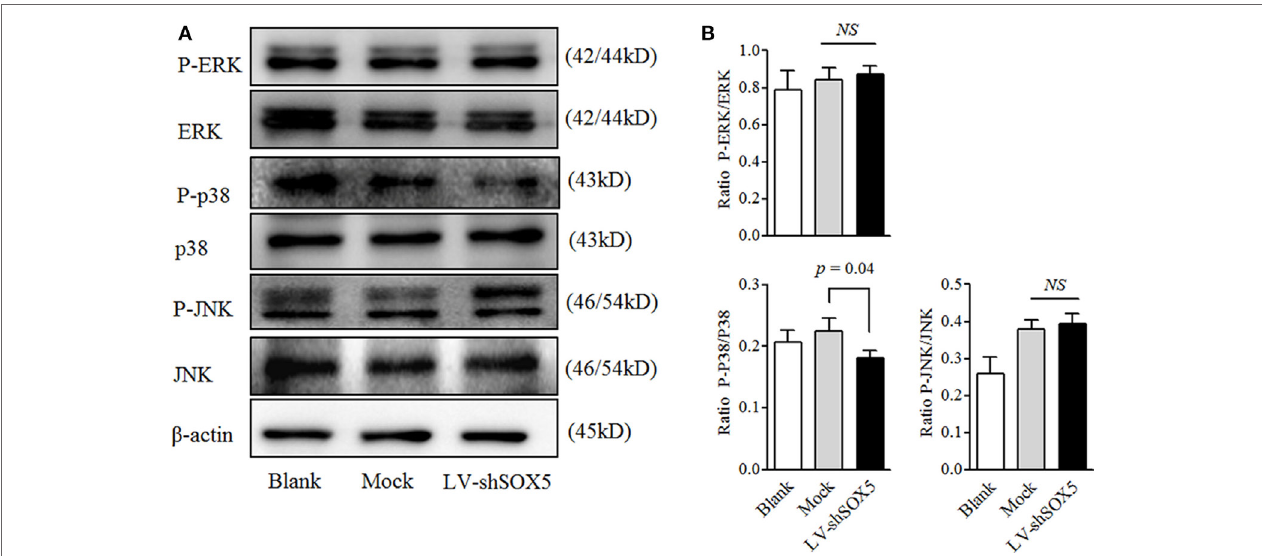
FigUre 5 | Knockdown SOX5 inhibits p38-MAPK phosphorylation in RA-FLS. (a) Following transfected with LV-shSOX5 or Mock for 96 h, cell lysates were subjected to western blotting analysis for the phosphorylation of ERK, p38, and JNK. The results are representative of three similar, independent experiments. (B) Graphs show the quantitation data derived from the left figure. Data are each representative of three independent